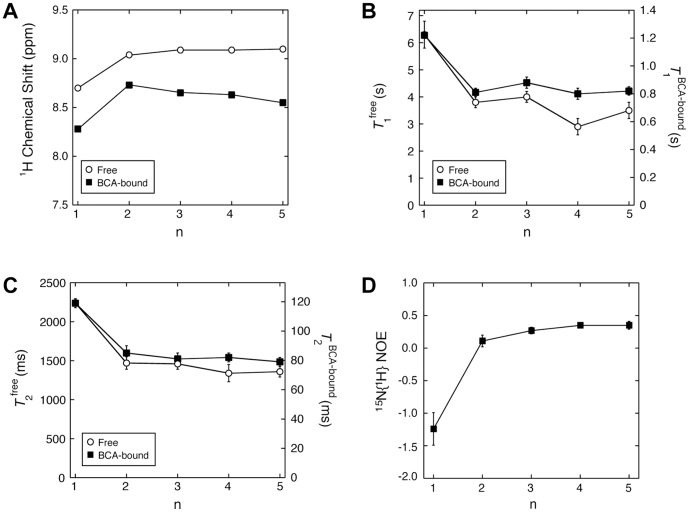
NMR data for the amide closest to the benzene ring (the “first” subunit) for benzenesulfonamide ligands with Gly chains (SA-Glyn).The variation of these NMR data with chain length (n) of the ligand are compared for the case when the ligands are free in buffered solution (open circles) and when they are in complex with bovine carbonic anhydrase II (BCA; closed squares). (A) Chemical shifts for the “first” amide proton exhibit a nearly constant difference between free and BCA-bound forms across the ligand series. 15N NMR relaxation times of T
1 (B) and T
2 (C) across the SA-Glyn ligand series exhibit a nearly constant relative decrease from the free to the BCA-bound forms (revealed by separate axes for free and for BCA-bound data). (D) Values of 15N-1H steady-state NOE for the SA-Glyn ligands when bound to BCA suggest a different dynamic environment for the SA-Gly1 ligand relative to the other, longer ligands (n≥2), for which the trend shows little dependence on chain length (n).